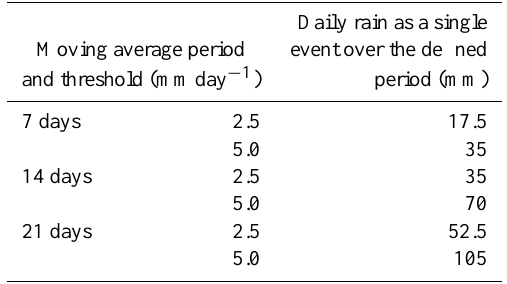
Table 2. The minimum daily rainfall event fully accounted in moving-average analysis over the set of considered periods and daily